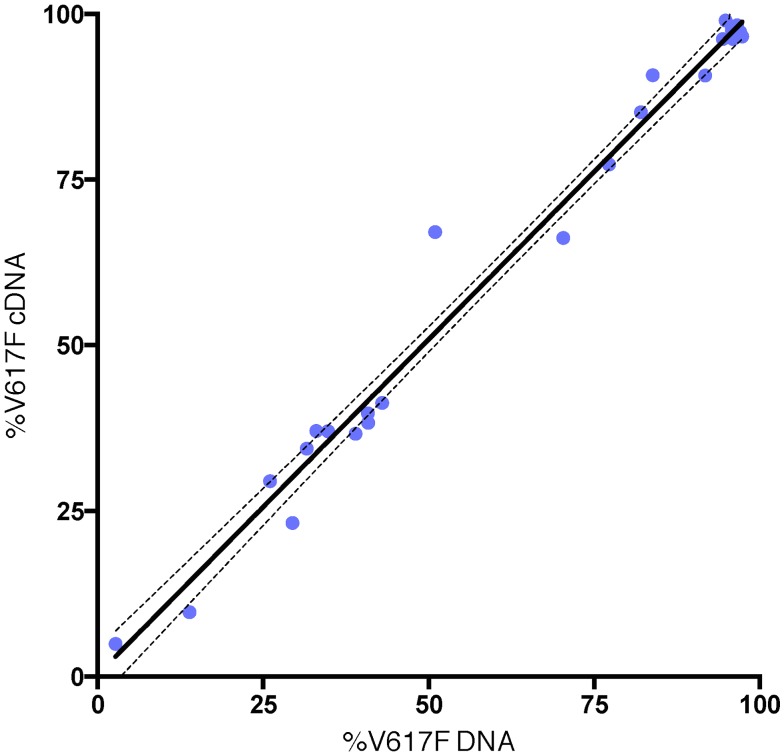
Regression analysis.Shows that the proportion of mutated alleles in the genomic DNA corresponds to the proportion of mutated transcripts (Y = 0.293 + 1.012 * x, R
2 = 0.983).